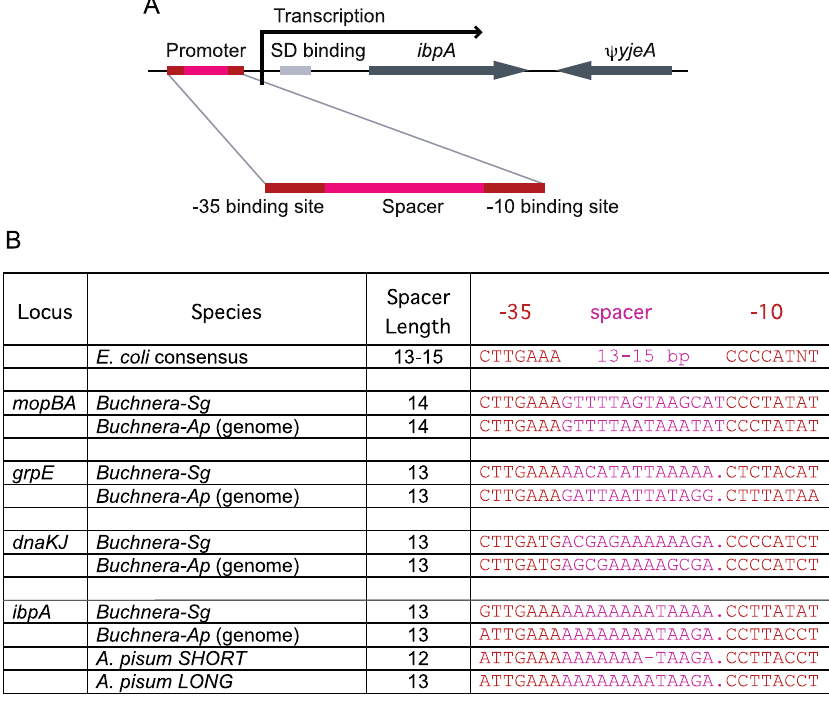
Figure 1. Heat-Shock Promoter Governing Expression of the Heat-Shock Gene ibpA in Buchnera (A) Schematic of regulation of ibpA expression showing position of heat-shock promoter. (B) Sequence of E. coli consensus heat-shock promoter and of all heat-shock promoters of Buchnera of S. graminum and of A. pisum . Sequences from published complete genome data were confirmed for both species. The only variant is the ibpA promoter allele, which has a shorter spacer length, resulting in almost complete loss of the heat-shock response of ibpA